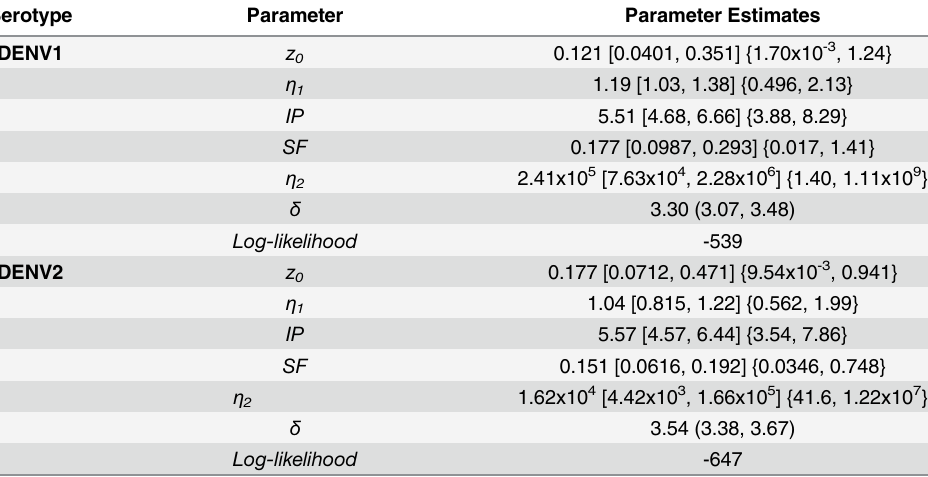
Table 2. Parameter estimates for the model with virus neutralisation, in which antibody removes virus (Model 2). The model was separately fitted to IgM data for DENV1 and DENV2 infections. For immune response parameters and the incubation period which are patient specific parameters, median (IQR) and min and max are reported. For the group-level parameter δ , the median and (95% CI) are reported. Parameters z 0 , η 1 , η 2 , IP and SF were fitted as patient specific and others as common to all patients in the fitted group. Serotype